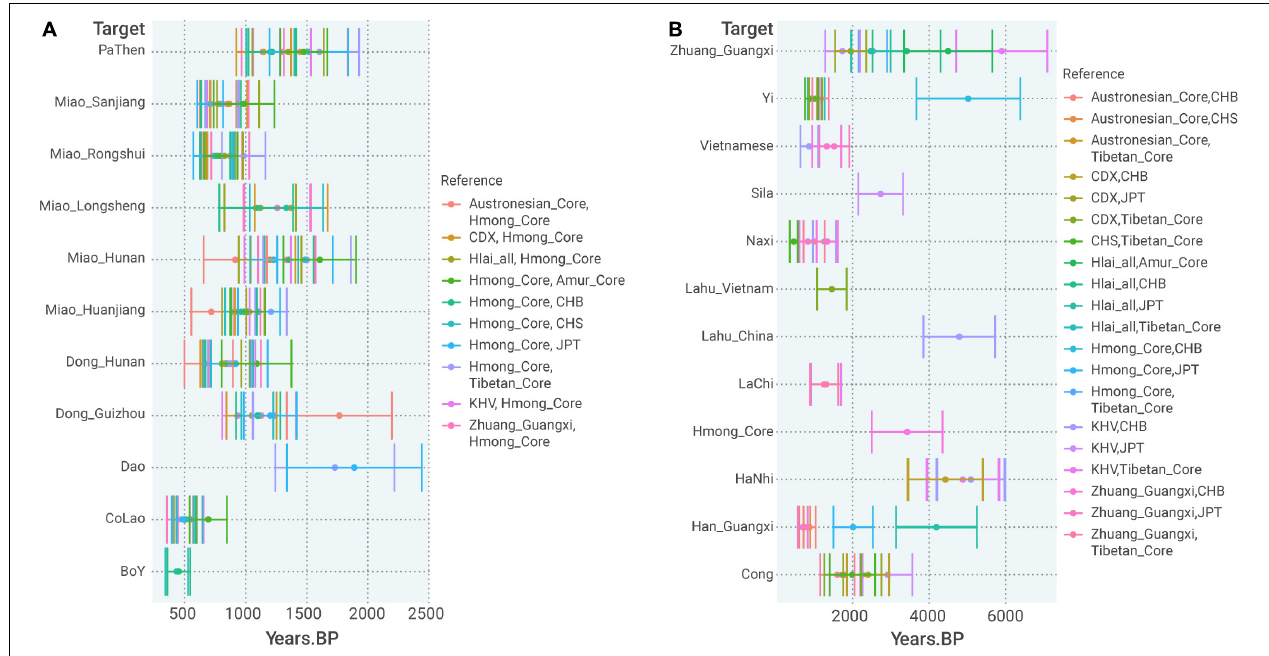
FIGURE 6 | Admixture time estimated by ALDER (A) admixture time estimation of populations in the Hmong–Mien Cline referenced by pairing Hmong_Core and a non-Hmong–Mien reference. (B) Admixture time estimation for admixture between Northern and Southern East Asians. The error bar denotes ± 1 standard